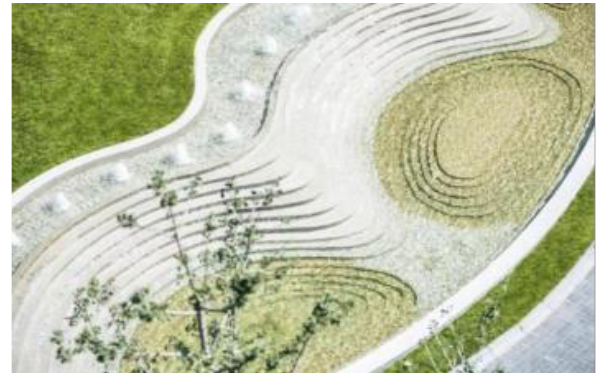
Figure 8. Anaya vegetation area .